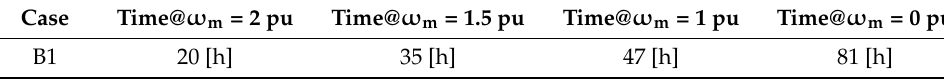
Table 5. FESS self-discharge performance (case